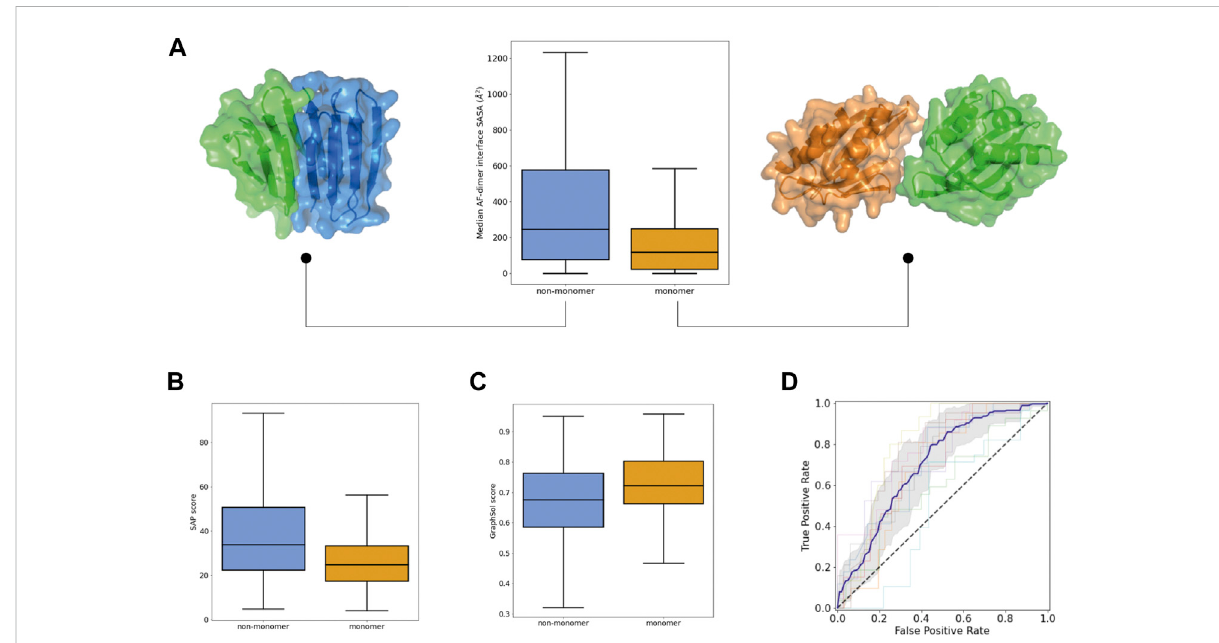
FIGURE 3 Propensity for self-interactions and soluble expression in the Monomer dataset. (A) Distributions of the interface area of the homodimers predicted by AlphaFold. For each protein sequence, the median value among the fi ve predictions is taken. Examples of small ( right ) and large ( left ) predicted homodimer interfaces for monomeric and non-monomeric designs. (B) Distributions of SAP scores calculated on the top-pLDDT AF model. (C) Distribution of GraphSol soluble expression scores. (D) ROC curves obtained from the 10-fold cross validation of a 8-descriptor classi fi cation model. The average ( blue line ) and standard deviation ( gray shaded area ) of the 10 ROC curves is